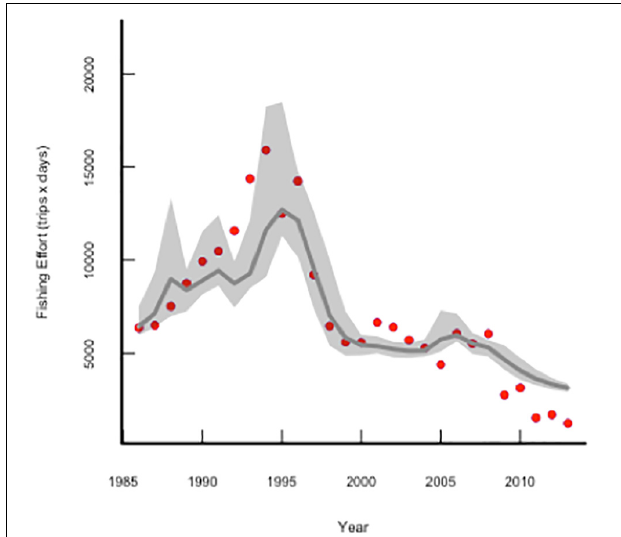
FIGURE 4 | Comparison of the observed changes in fishing effort (number of trips × days out of port, red dots) with the predictions from models (gray line) ( Table 2 ).